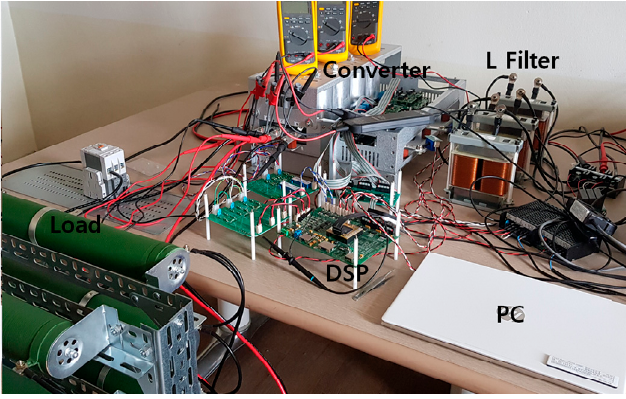
Figure 9. Photograph of the experimental prototype.